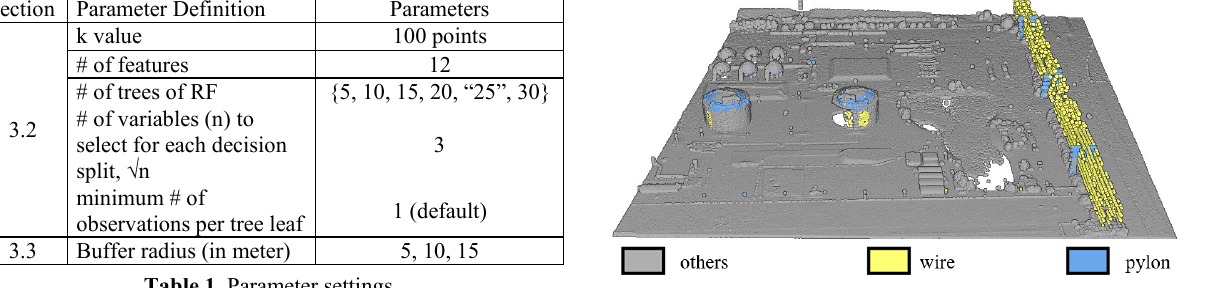
Figure 4. Classification result of a part of the test set.